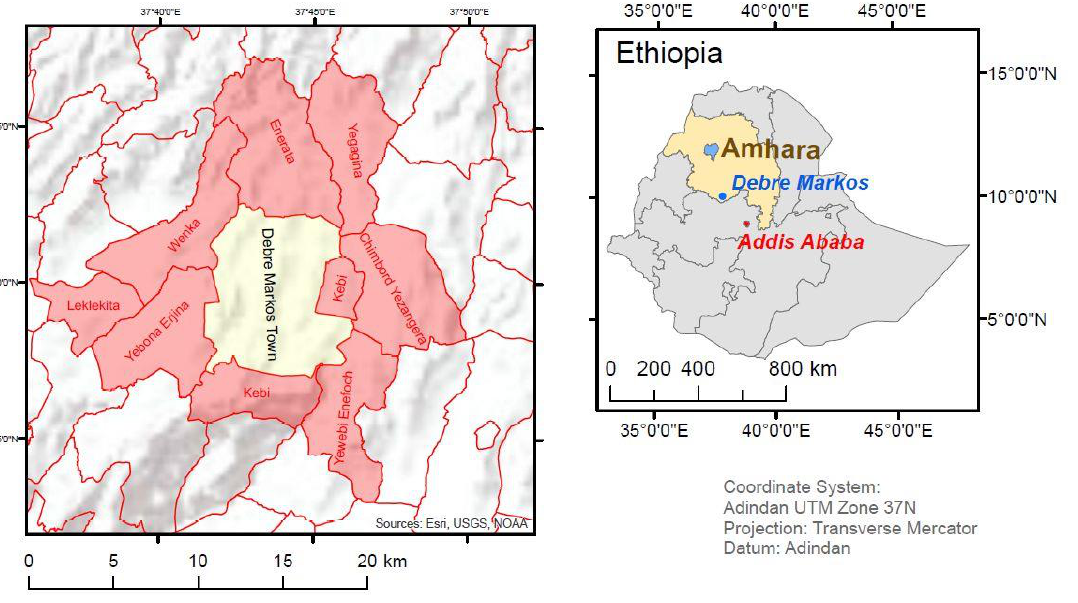
Figure 1. Map of the study areas.